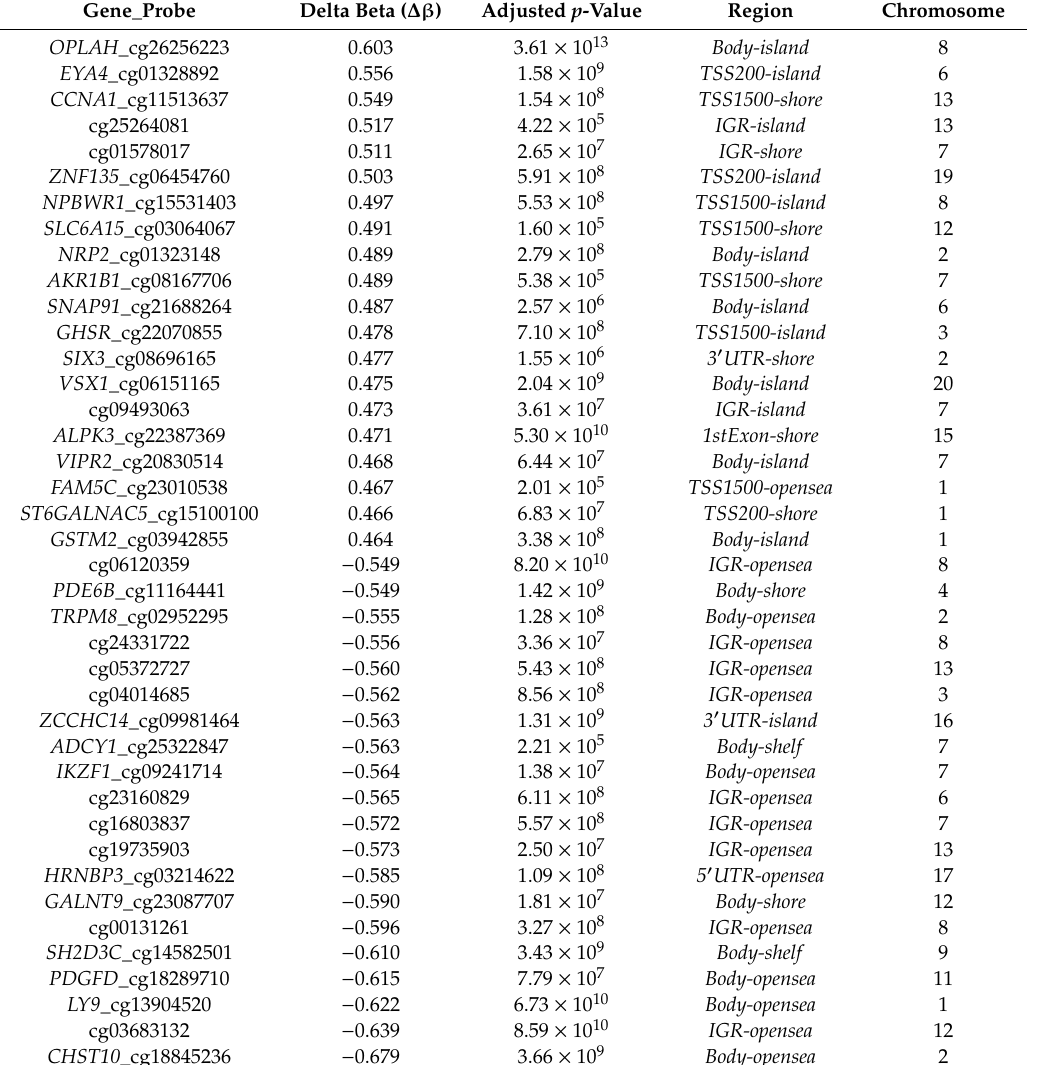
Table 1. Forty topmost significant di ff erentially methylated probes in open